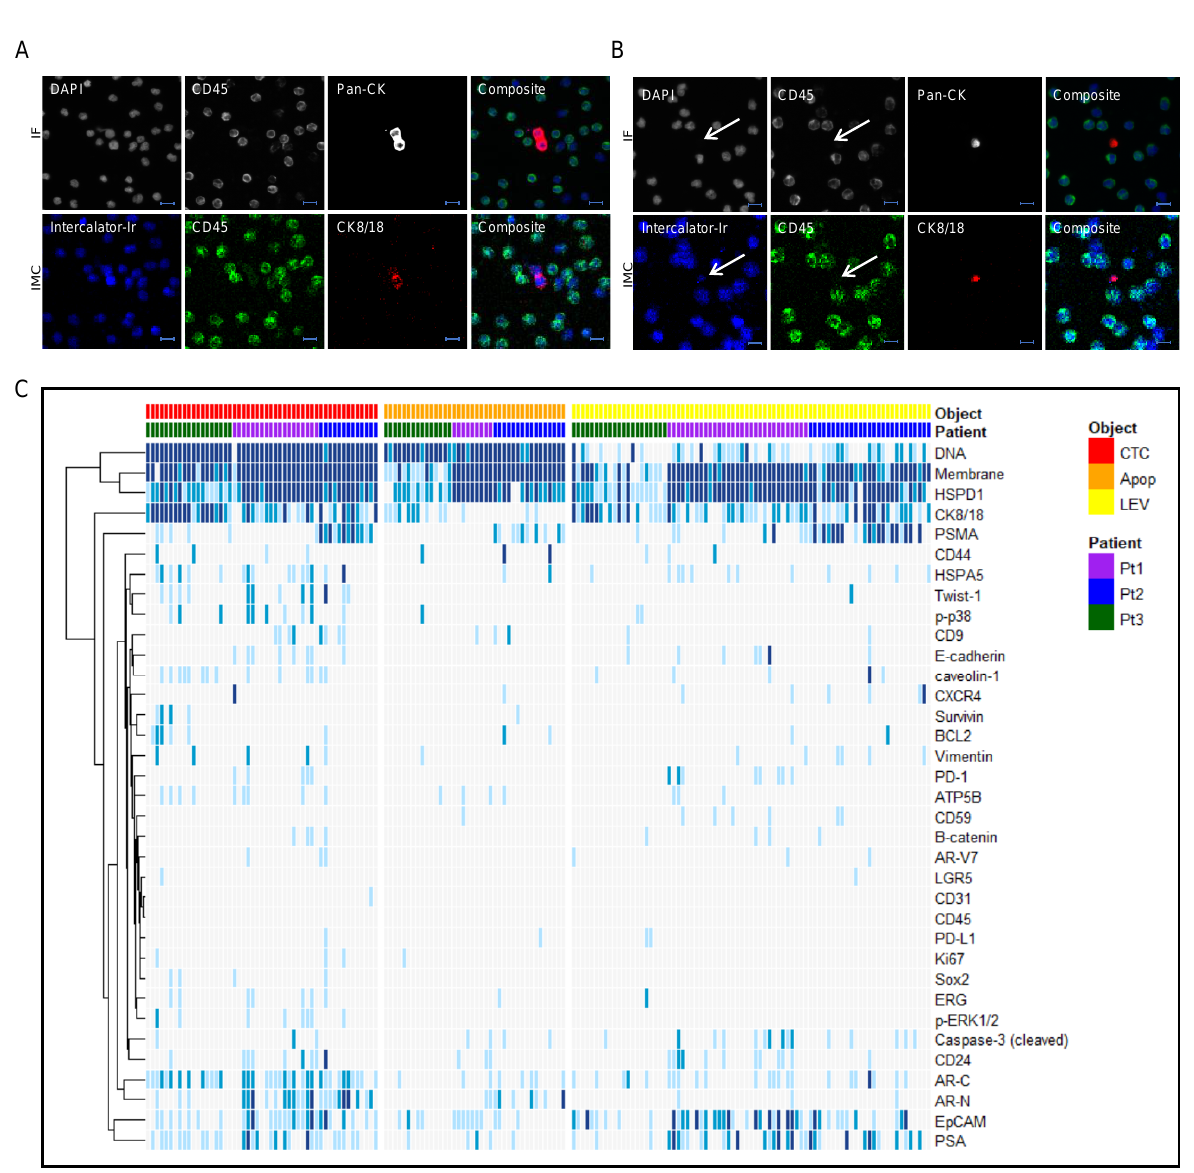
Figure 2. Multiplex protein profiling of CTCs and LEVs. ( A , B ) Example of IF (top panels) and IMC (bottom panels) images of a CTC ( A ) and a LEV ( B ). The arrow points at the LEV which is negative for DAPI and weakly stained by the IMC DNA intercalator. Scale bar is 10 µ m. ( C ) Heatmap of IMC scores on a 0–3 scale with 0 = white and dark blue = 3, ordered by object categories and patients, and clustered by